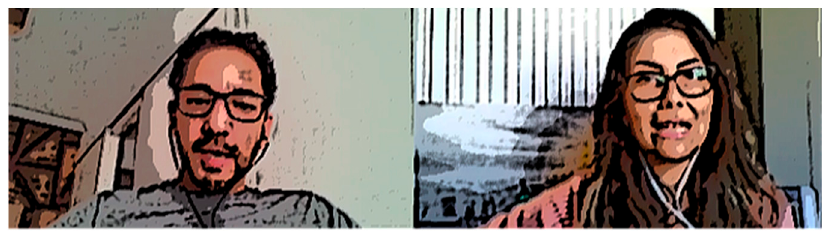
Figure 1. To the left , Ivo (the tutee); to the right , Mari (the tutor). As stated earlier, the lessons were not based on any pre-assigned course material and were designed by the tutor as mostly comprising conversational practice that was very seldom interrupted for corrections (most corrections were done after the session via WhatsApp or a shared editable file). When there were specific grammatical or lexical units pre-prepared by the tutor, they often drew on issues that emerged during the sessions or related